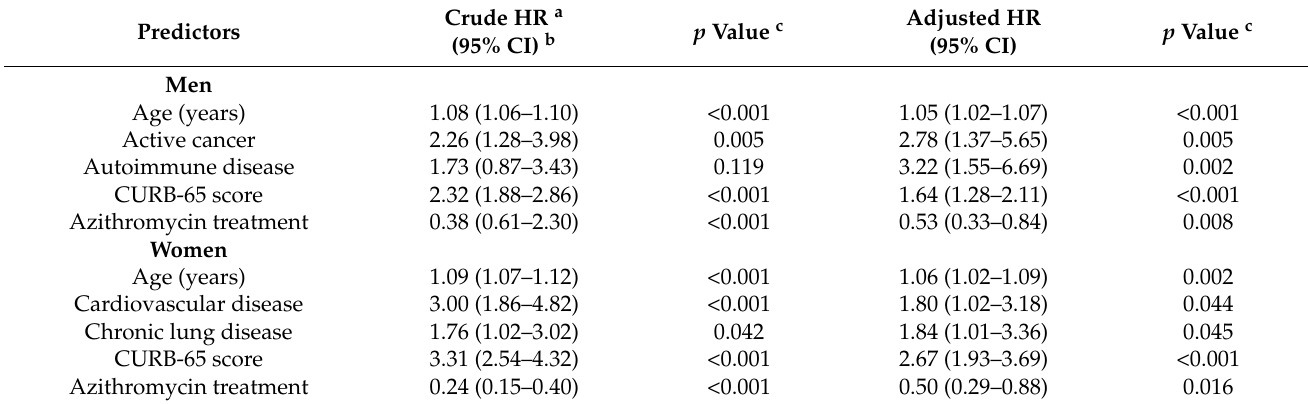
Table 2. Cox regression models for in-hospital mortality among men and